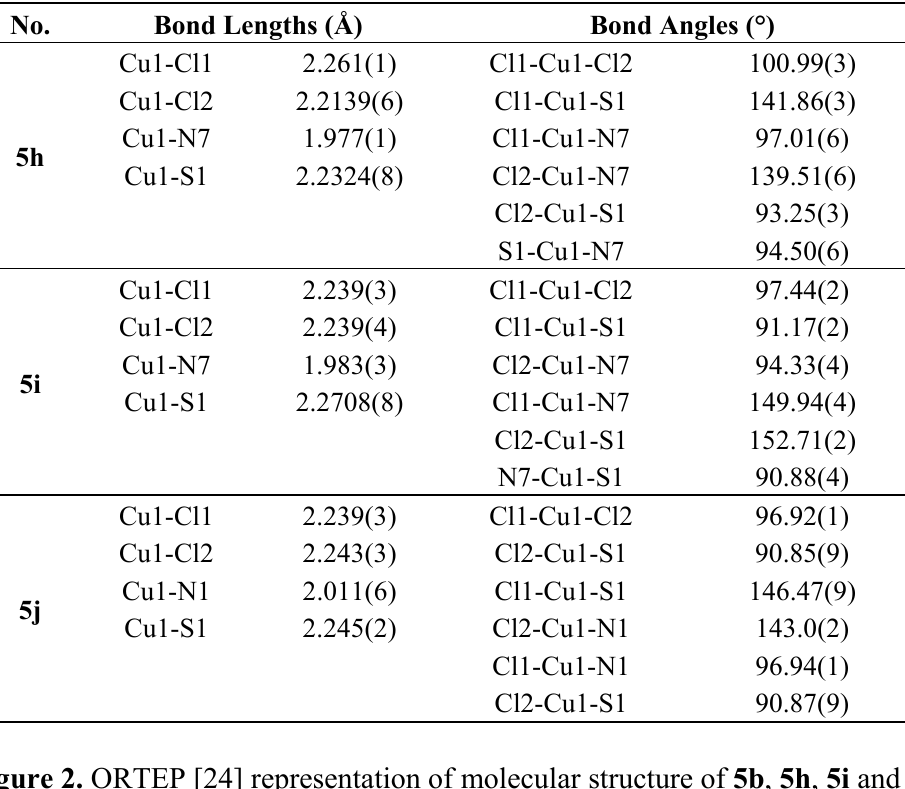
Figure 2. ORTEP [24] representation of molecular structure of 5b , 5h , 5i and 5j